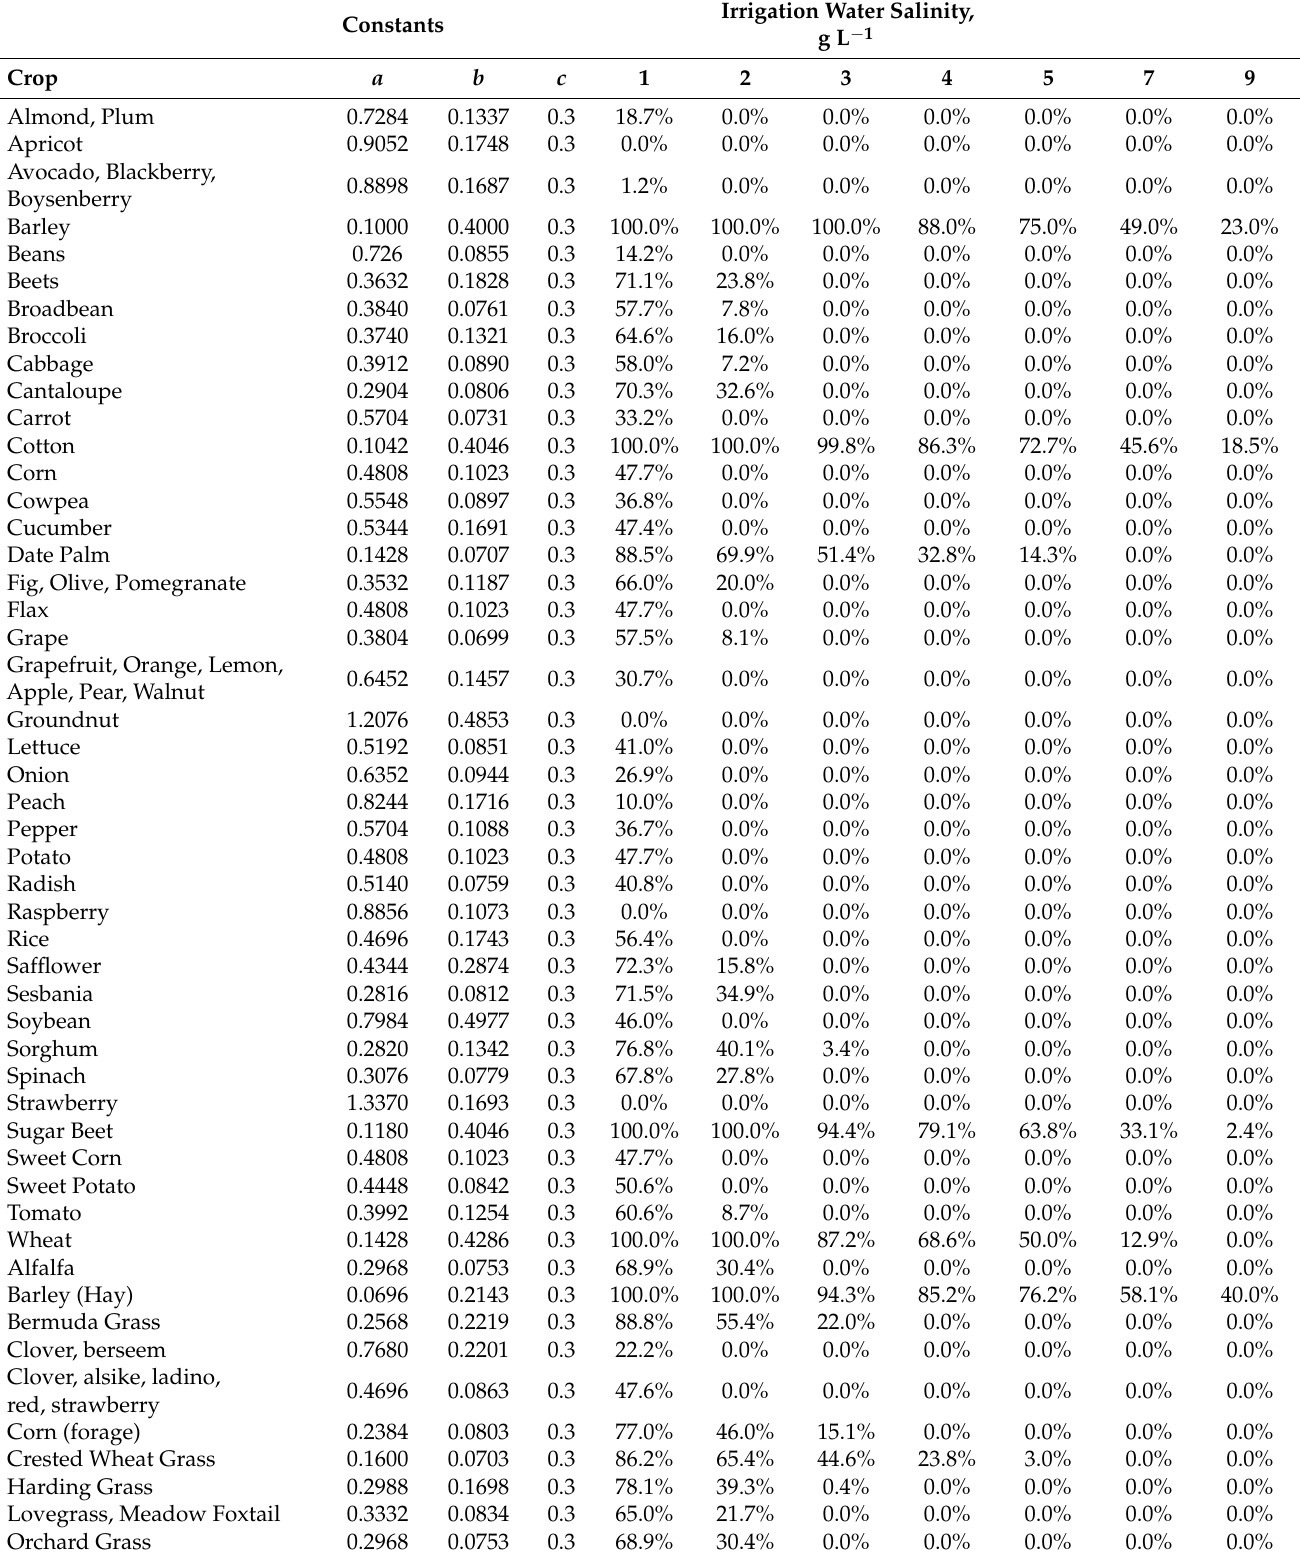
Table A4. Indicative relationship between crop type, irrigation water salinity, and crop yield relative to crop yield when irrigated with